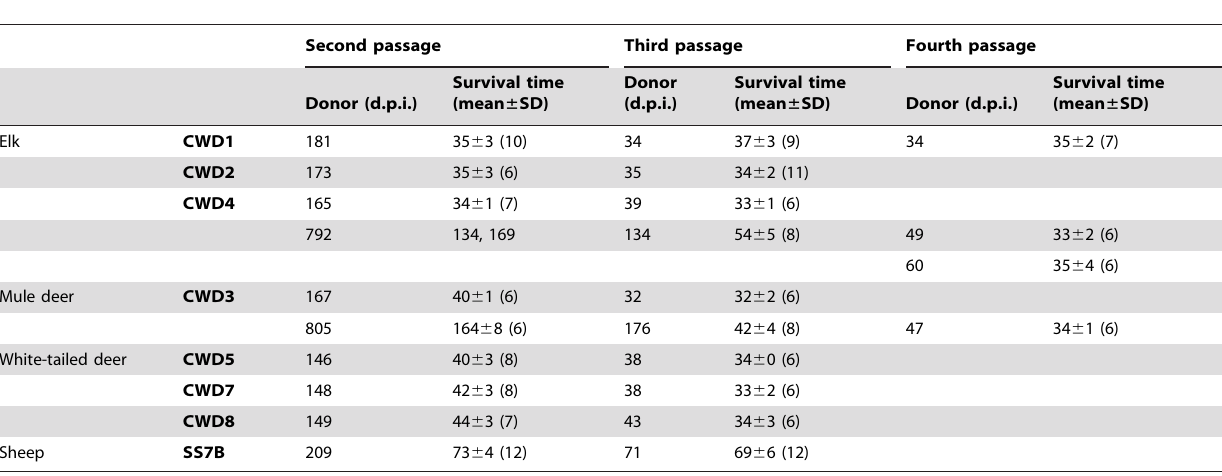
Table 2. Survival times of Bv109I and Bv109M after subsequent passages of